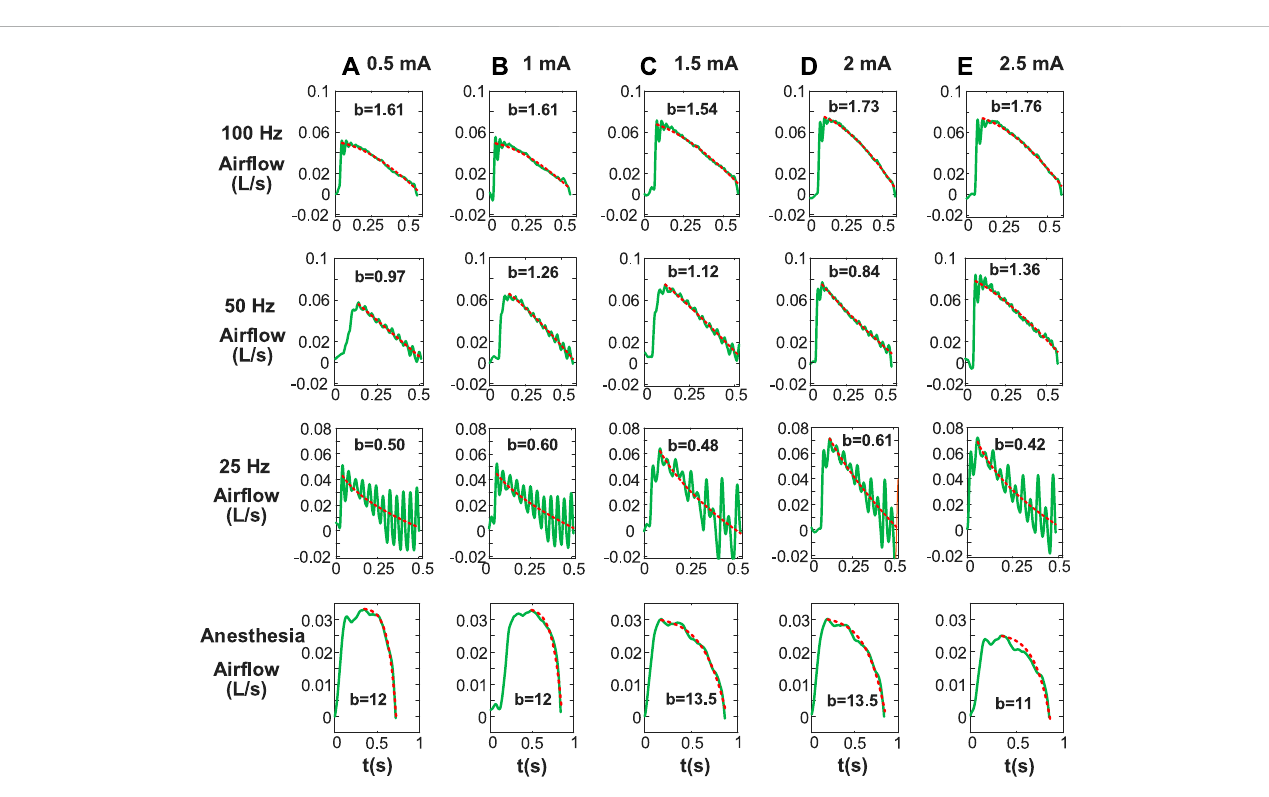
FIGURE 5 Air fl ow Index (b) for inspiratory phase including paced breathing and anesthesia. Stimulus amplitudes [ (A) 0.5 mA, (B) 1 mA, (C) 1.5 mA, (D) 2 mA, (E) 2.5 mA] with various stimulus frequencies are different. Other stimulus parameters are same. b is obtained by fi tting inspiratory air fl ow waveforms with Eq. 1. The b values under anesthesia are signi fi cantly different from that under diaphragm